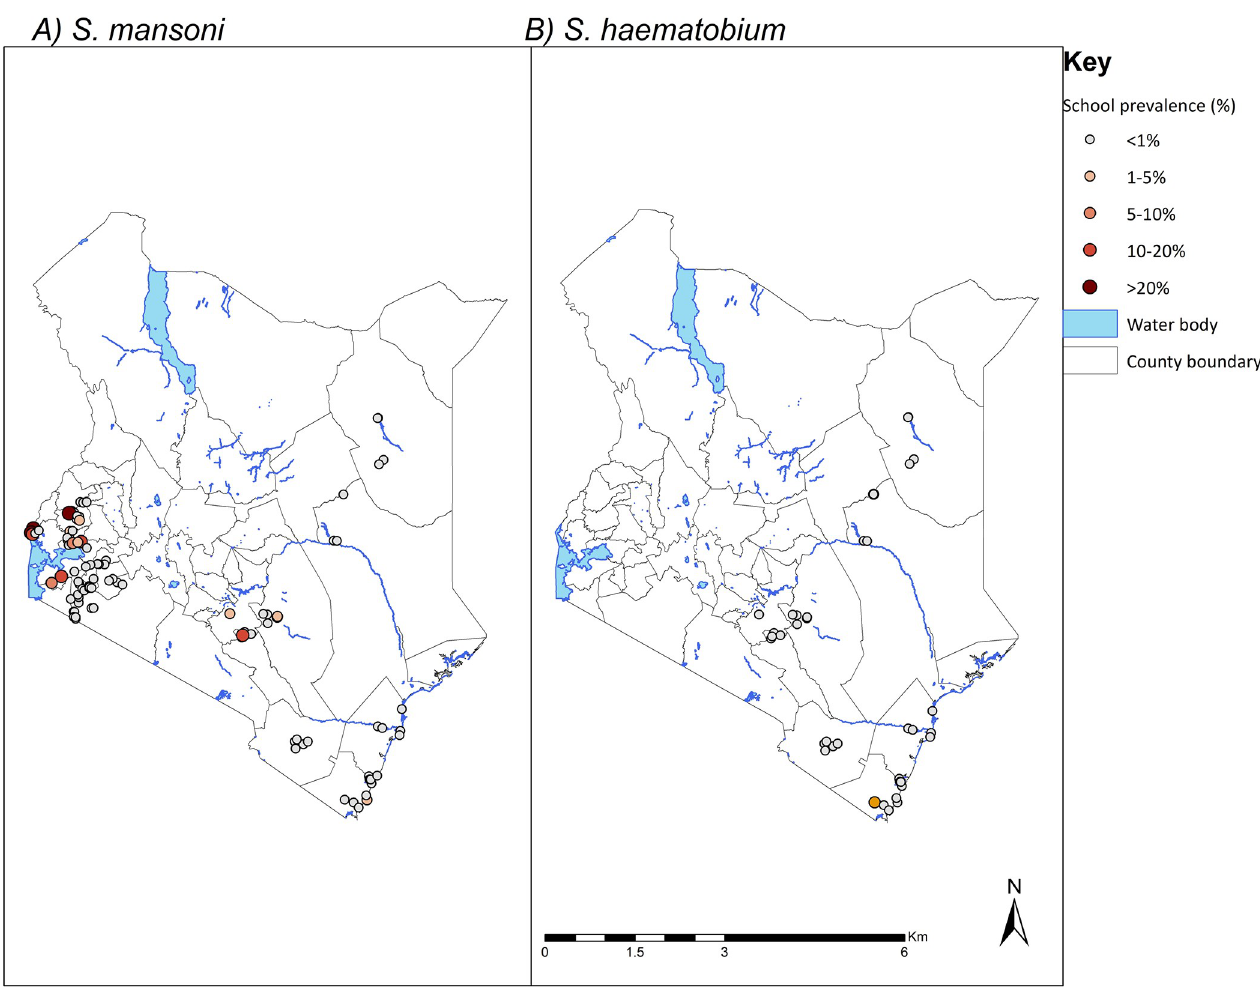
Fig 2. Schistosomiasis prevalence distribution after five years of deworming in